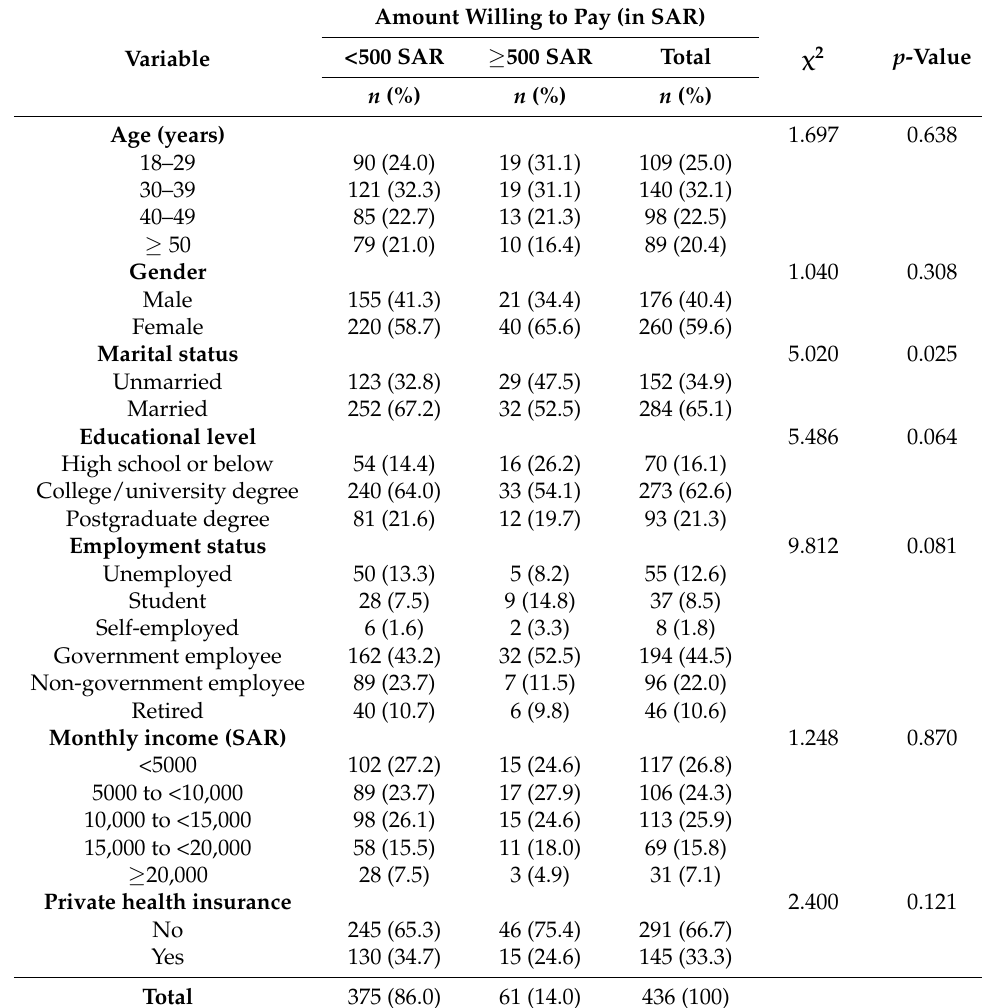
Table 3. Bivariate analysis of socioeconomic factors and the maximum amount respondents were willing to pay for immediate public dental